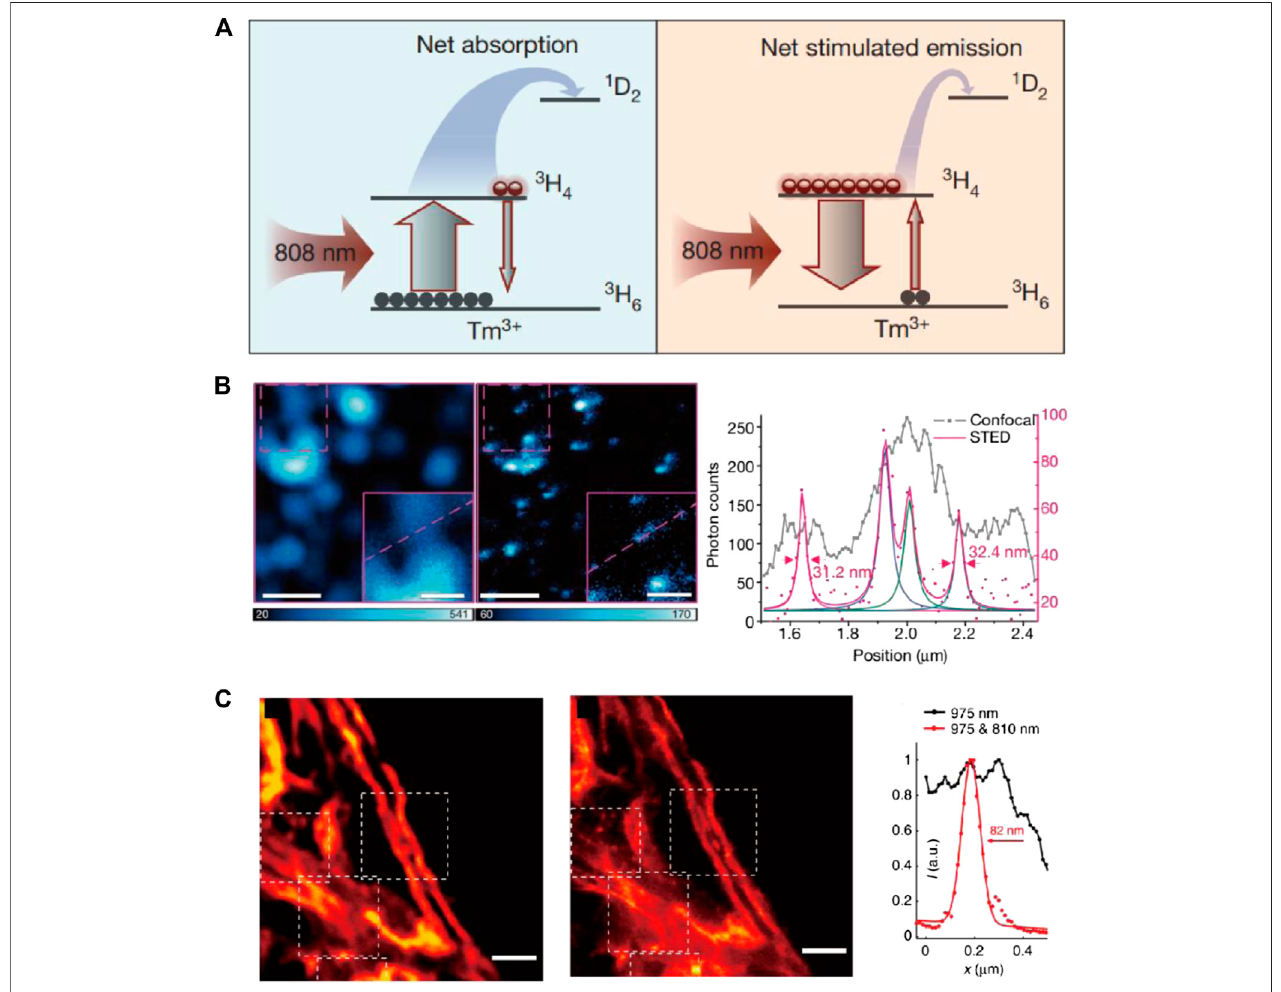
FIGURE 9 | STED performance of UCNPs. (A) The diagram of involved energy levels in STED process of Tm-doped UCNPs. (B) Particle imaging results and intensityplot fi lesofTm-dopedUCNPswithconfocalandSTEDimagingsetup(Liuetal.,2017). (C) ConfocalandSTEDimagesofcellskeletonslabeledwithUCNPsand corresponding plot fi les (Zhan et al.,